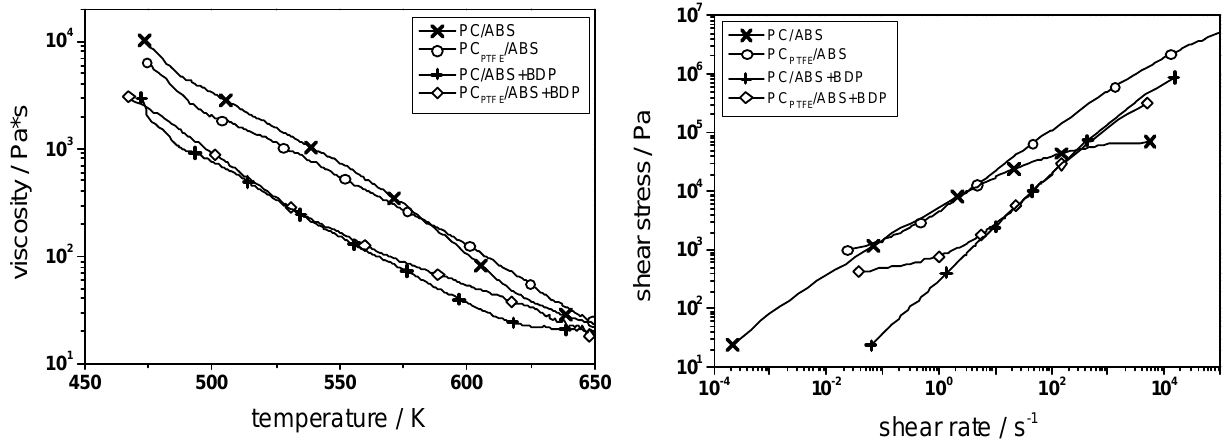
Figure 10. Rheology for PC/ABS, PC BDP works as plasticizer reducing the viscosity; PTFE works as an anti-dripping agent increasing the viscosity towards the decomposition temperature and introducing a flow limit at low shear